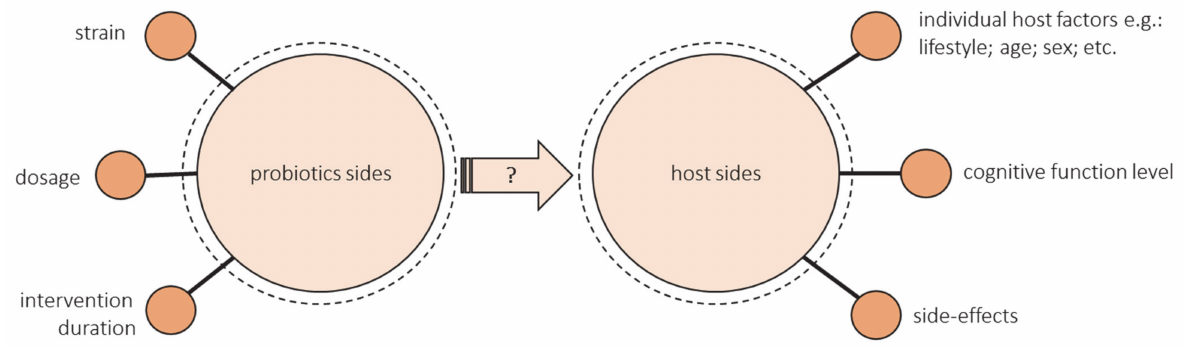
Figure 2. Unknowns that require clarification and parameters that need to be controlled from the probiotic and host sides in planning of intervention